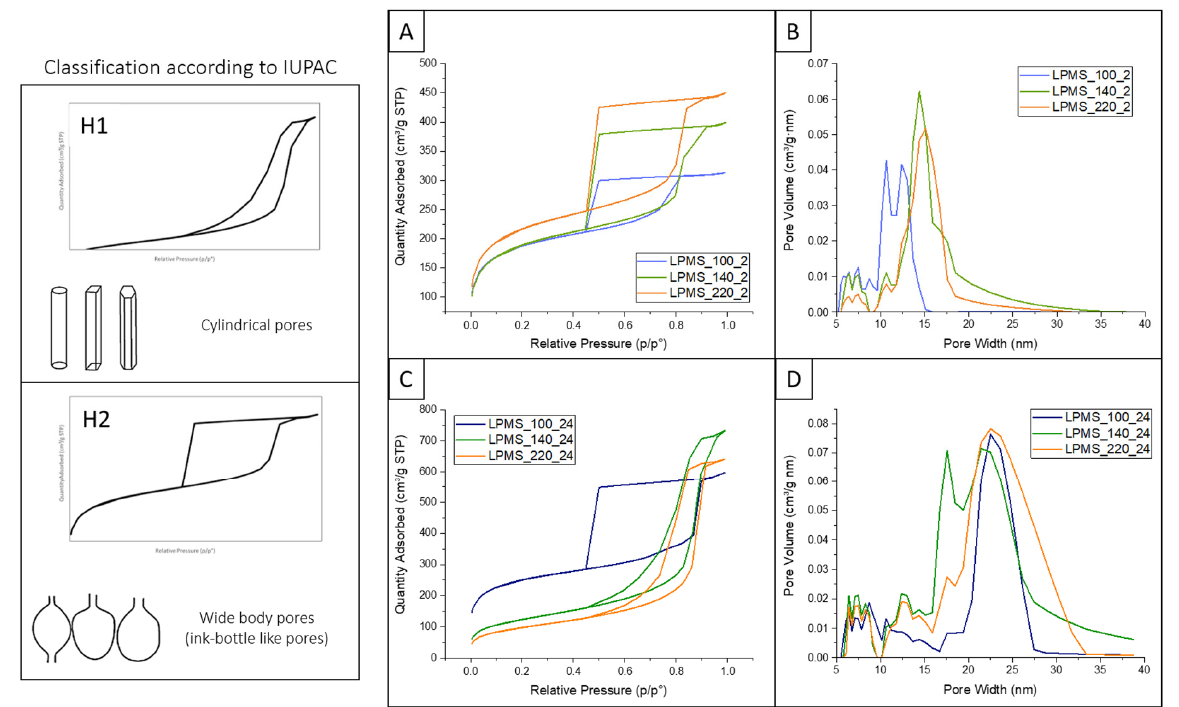
Figure 2. N 2 adsorption-desorption isotherms and pore size distributions of synthesized LPMSs using different temperatures and durations of the hydrothermal treatment: LPMSs obtained with 2 h ( A , B ) and 24 h ( C , D ) of process, respectively. The classification of hysteresis loop according to pore types is reported to the left (according to reference [86]). Table 1. Specific surface area (S BET ), pore volume and average pore size of synthesized LPMS ma- terials.